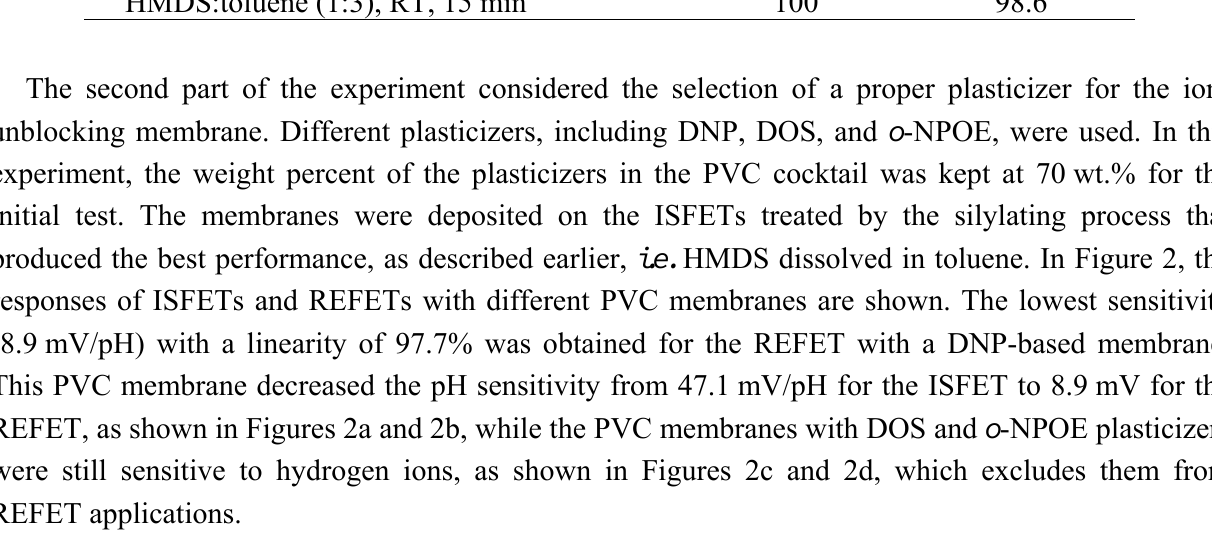
Table 1. Silylating process for Si